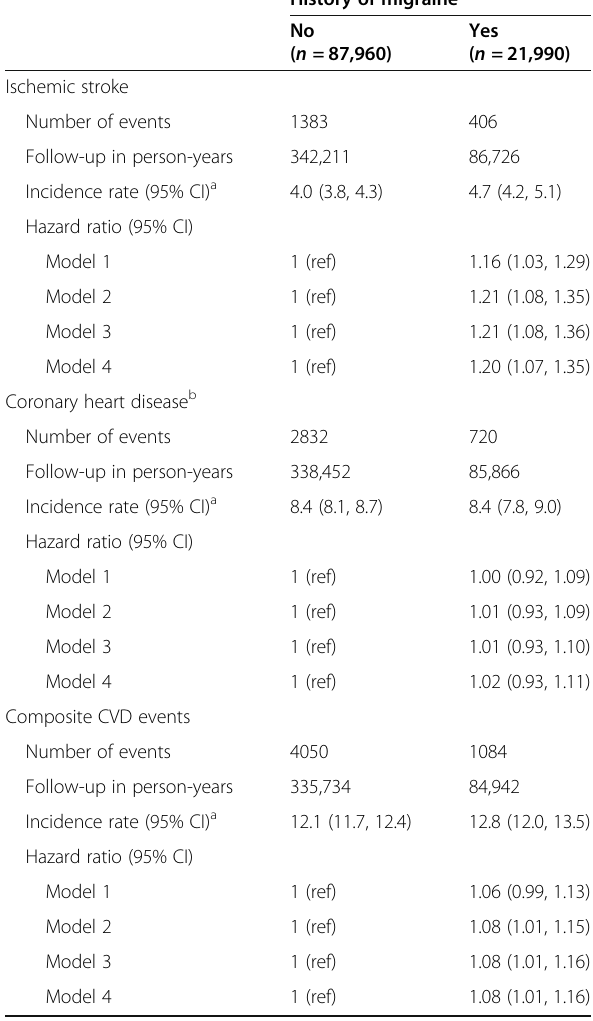
Table 2 Incidence rates and hazard ratios for ischemic stroke, coronary heart disease and cardiovascular disease events associated with a history of migraine among patients without a history of cardiovascular disease